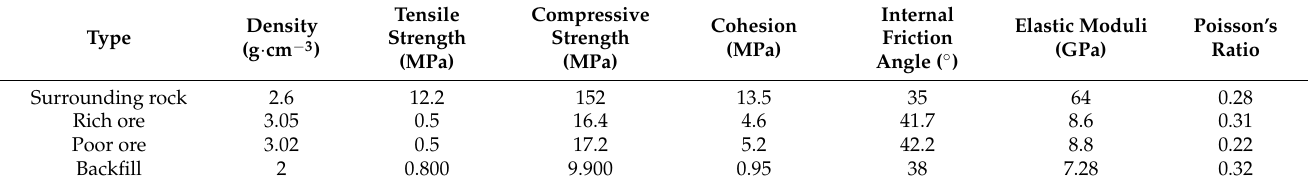
Table 1. Rock and backfill mechanical parameters in mining area No.